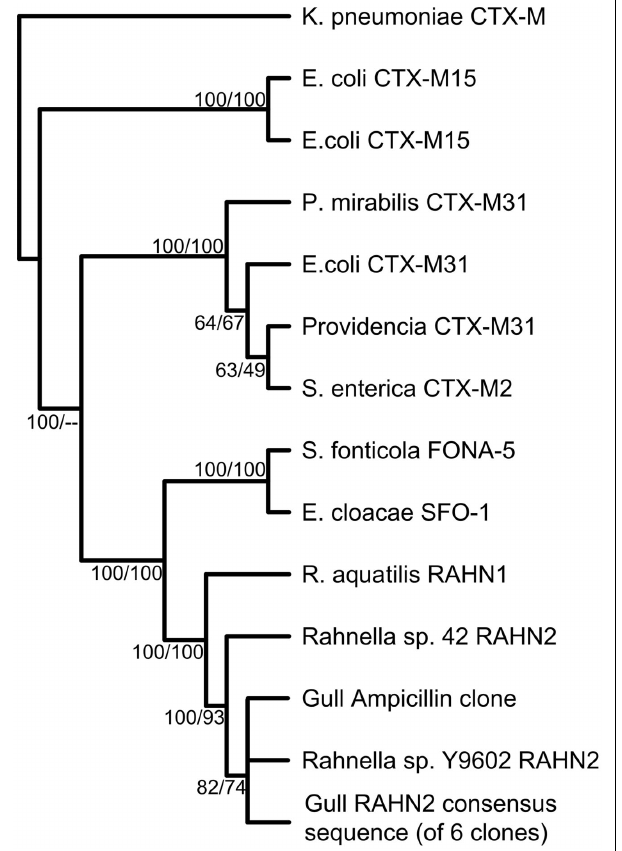
FIGURE 1 | Phylogenetic tree of the bl2be_ctxm type classA β -lactamase gene from metagenomic clones. The phylogenetic tree is a majority rule consensus tree based on protein similarity using neighbor-joining. Bootstrap values (total 100) are calculated with neighbor-joining and maximum likelihood methods. Klebsiella pneumoniae CTX-M is the outgroup.